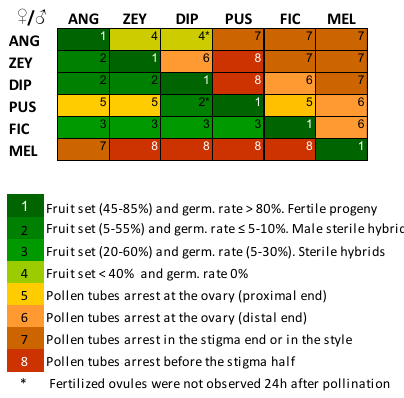
Figure 1. Patterns of crossability in a complete 6 × 6 diallel cross between Cucumis species, including both reciprocal crosses and self-pollinations (table’s diagonal). Crossability index (CI) is indicated by numbers (1–8) and color grading (green to red) and ranges from crosses showing no IRBs (level 1) to crosses impeded early after pollination (level 8). CI is determined by pre-zygotic IRBs that result in pollen tube arrest at different pistil parts (5–8) and post-zygotic IRBs that condition fruit set success, seed viability (germination rate), and hybrid fertility (1–4). Fertilized ovules were observed 24 h after pollination in all crosses with CI 1–4 (green color grade) except for those labeled with